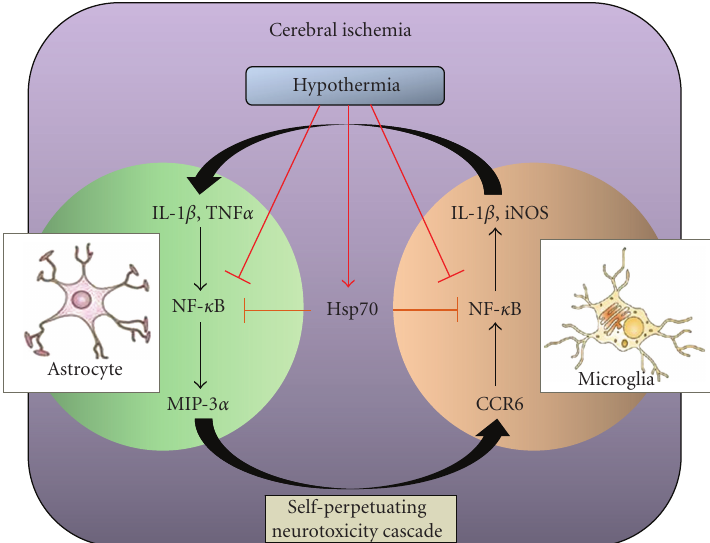
Figure 4: A putative neuroinflammatory cascade exacerbated by MIP-3 α -CCR6 signaling and protected by Hsp70 in ischemic rat brains. In ischemic brains, the activation of neuroinflammatory cascades including MIP-3 α -CCR6 signaling is speculated to progress as follows: astrocytes activated by proinflammatory cytokines like IL-1 β and TNF α stimulate MIP-3 α release. MIP-3 α activates microglia through CCR6 and the cells produce other stress-related proteins like iNOS and IL-1 β . Production of IL-1 β further accelerates astrocyte activation. The self- perpetuating neurotoxicity cascade may damage surrounding neurons and brain tissues. On the other hand, hypothermia suppresses the cytokines and chemokines production in part by direct inhibition of NF-kB transcription via decreased IkB kinase activity. Our experiment has also elucidated the potential e ff ect of hypothermia, which stimulated Hsp70 production in MCAO brains. Accumulated Hsp70 may inhibit NF-kB transcription by directly interacting with the NF-kB:IkB complex in astrocytes and microglia.